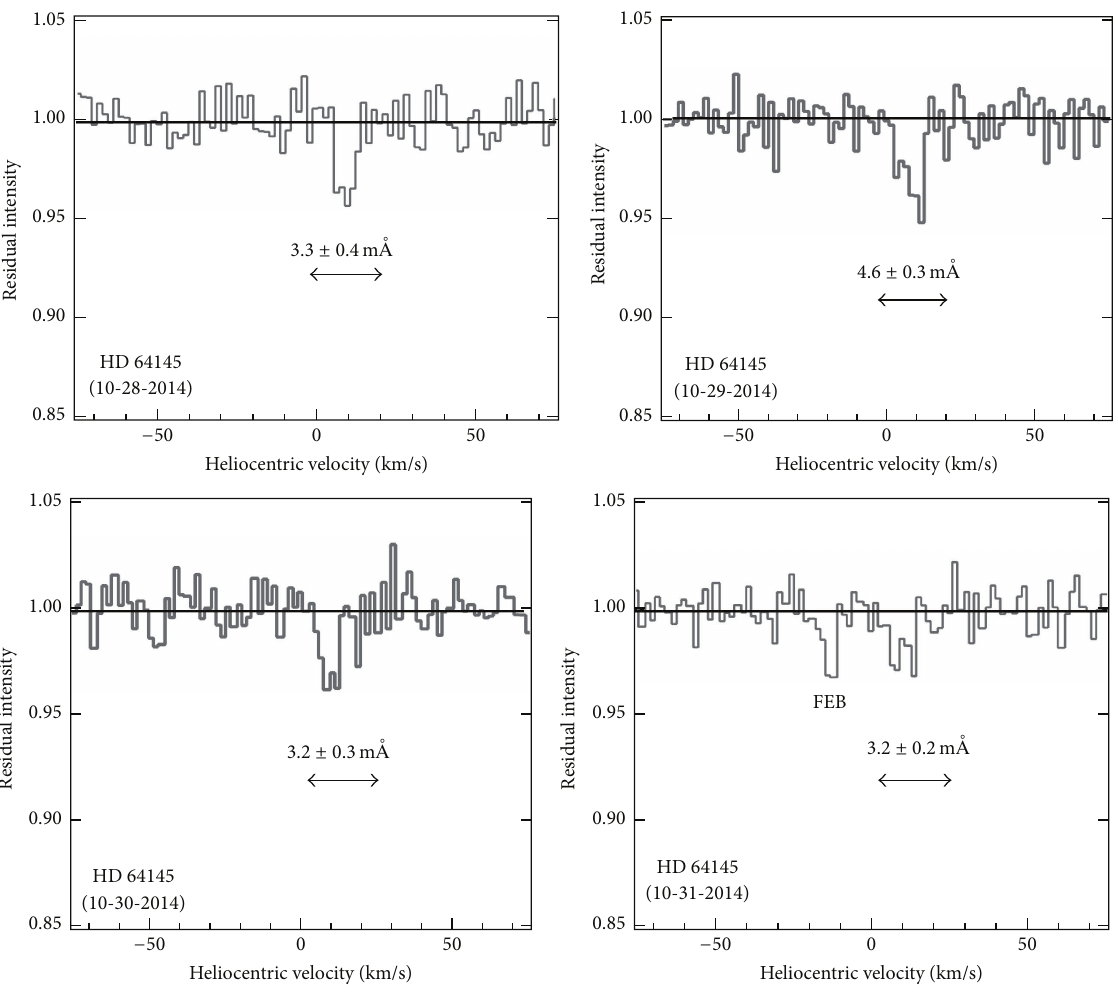
Figure 1: The circumstellar CaII K-line absorption spectra of HD 64145 recorded on 4 nights in October 2014. Note the appearance of an extra absorption feature centered at 𝑉 ∼ −15 kms −1 on the night of 10-31-2014, which is probably an FEB event.